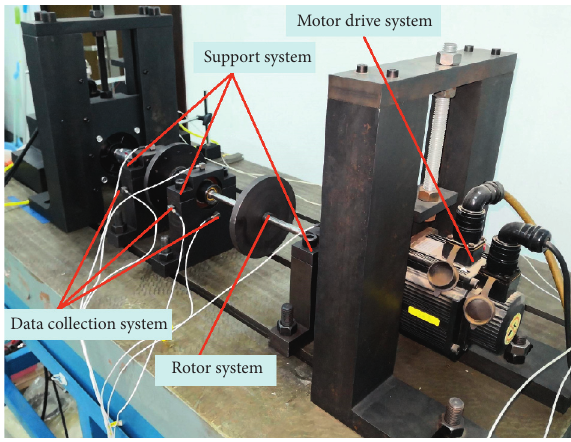
Figure 6: Birotor test rig of intershaft